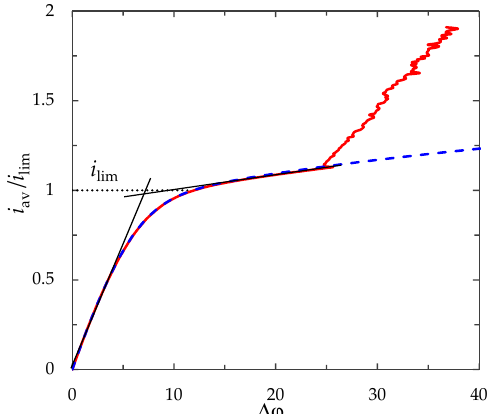
Figure 5. Current–voltage characteristic (CVC) calculated with (solid line) and without (dashed line) taking into account electroconvection. The dotted line shows the limiting current density, i lim , calculated using Leveque's Equation (23).